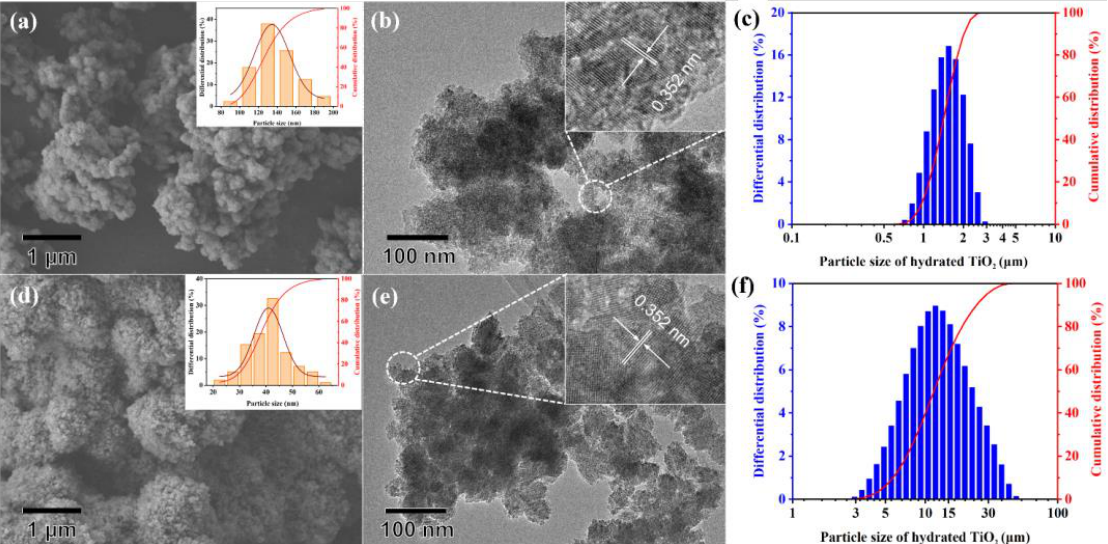
Figure 2. ( a ) SEM of hydrated TiO 2 prepared from the Mg/Al-bearing TiOSO 4 solution with an illustration of the primary agglomerate particle size distribution; ( b ) TEM of hydrated TiO 2 prepared from the Mg/Al-bearing TiOSO 4 solution; ( c ) Aggregate particle size distribution for the Mg/Al-bearing TiOSO 4 solution; ( d ) SEM of hydrated TiO 2 prepared from the TiOSO 4 solution with an illustration of the primary agglomerate particle size distribution; ( e ) TEM of hydrated TiO 2 prepared from the TiOSO 4 solution; ( f ) Aggregate particle size distribution for the TiOSO 4 solution.